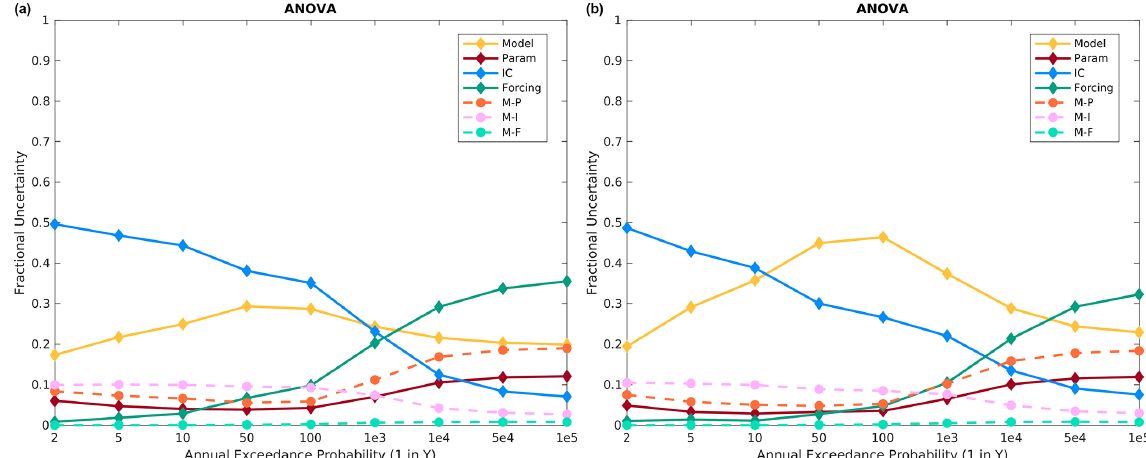
Figure 10. Island Park fractional variance contributions for the three most responsive model structures (i.e., structures associated with the largest runoff/precipitation ratio), namely HEC-HMS (model 1), HEC variant (model 4), and a SAC-SMA/HEC-HMS combination (model 6), for the (a) specified meteorological sequence and (b) historical meteorological